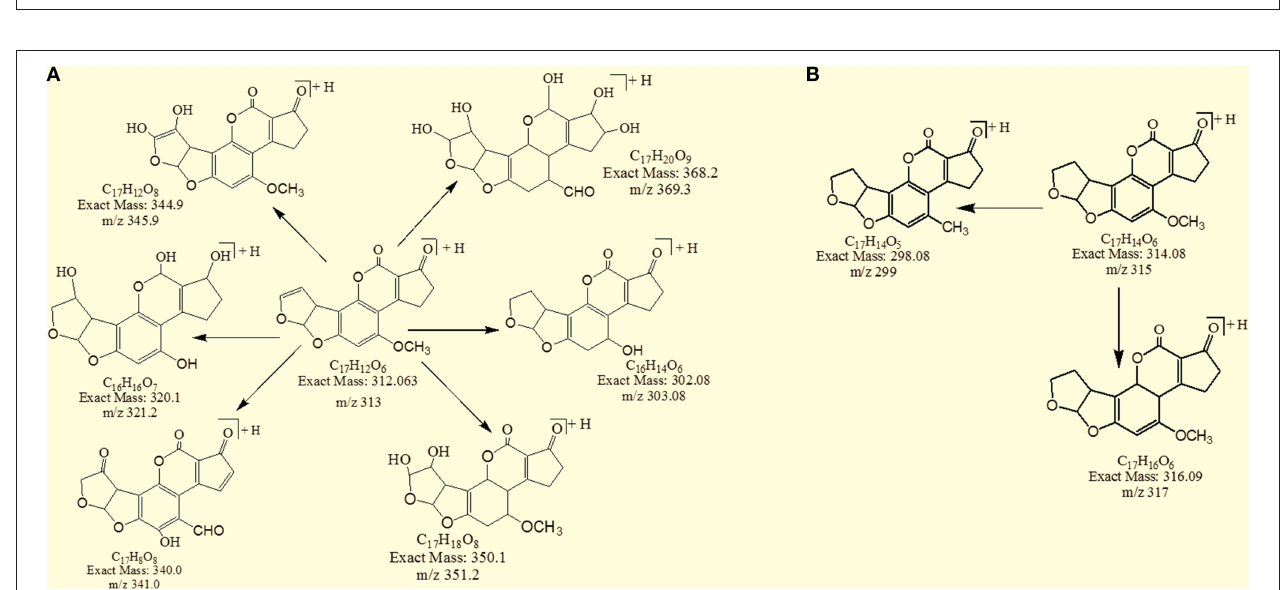
FIGURE 3 | MS/MS Spectra and fragmentation pathway. (A) AFB1 and (B) AFB2.